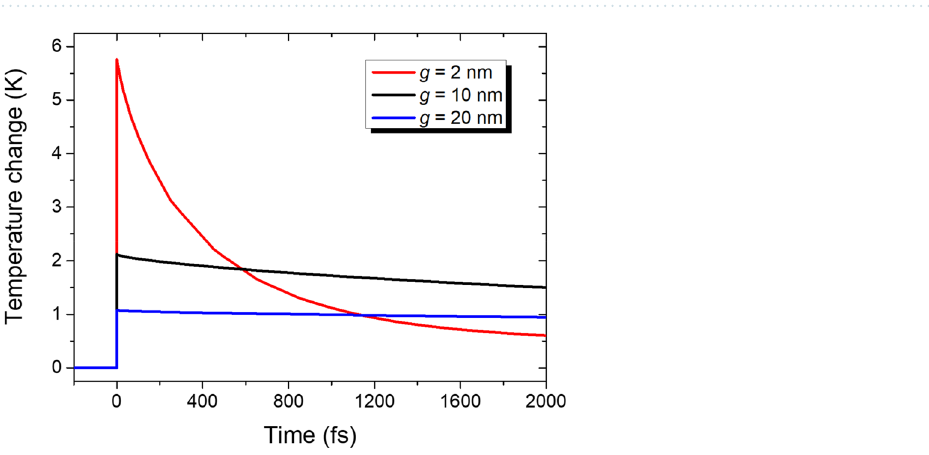
Figure 5. Time evolutions of the VO 2 nanogap temperatures for gap widths g of 2, 10, and 20 nm. It is assumed that LWIR irradiation of respective resonant wavelengths is instantaneously incident at 0 fs with an energy of 5 fJ per unit